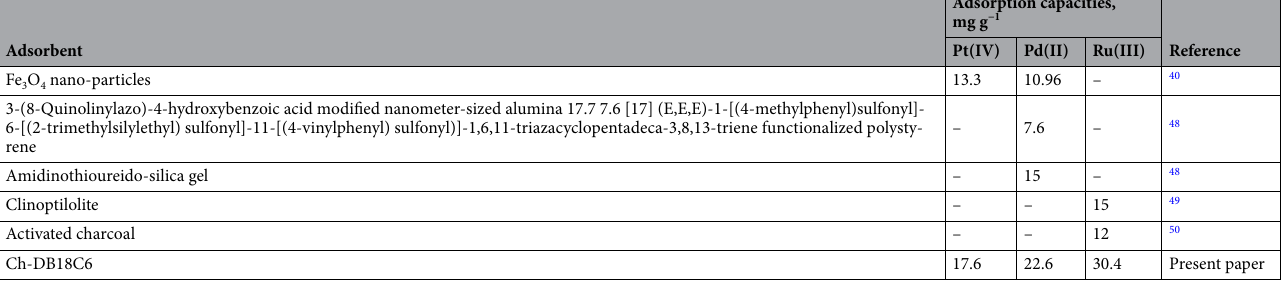
Table 7. Adsorption capacities of some adsorbents cited in the